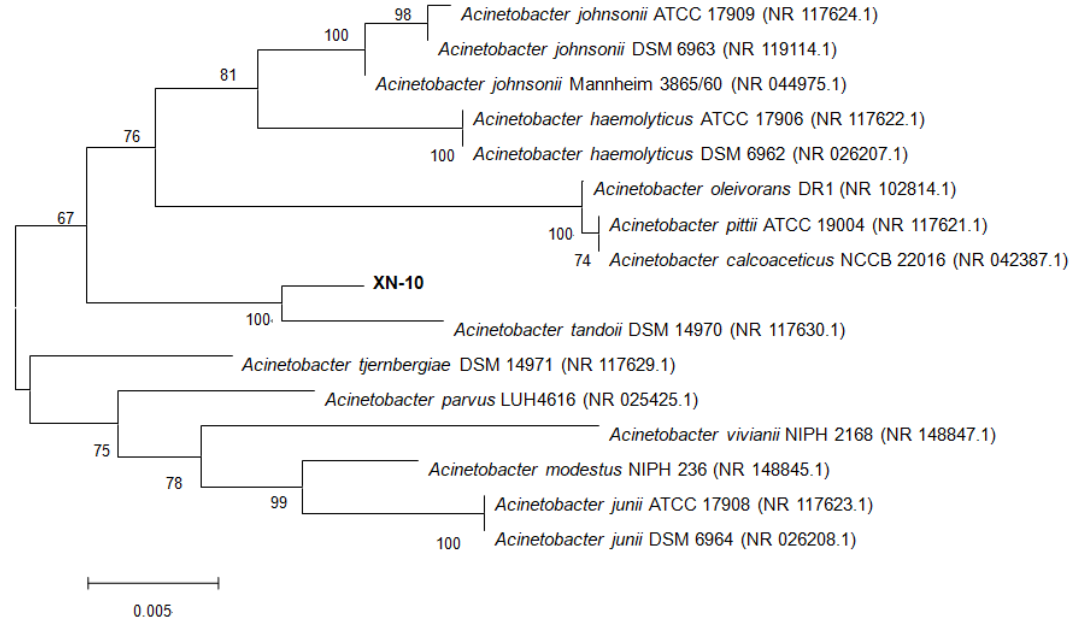
Figure2. Phylogeneticanalysisbasedonthe16SrRNAsequenceofstrainXN-10andotherrepresentative Acinetobacter strains. The phylogenetic tree was constructed with the neighbor-joining (NJ) method. Numbers in parentheses represent the sequence accession numbers in GenBank. Numbers at the nodes indicate bootstrap values from the neighborhood-joining analysis of 1000 resampled datasets. Bars represent sequence